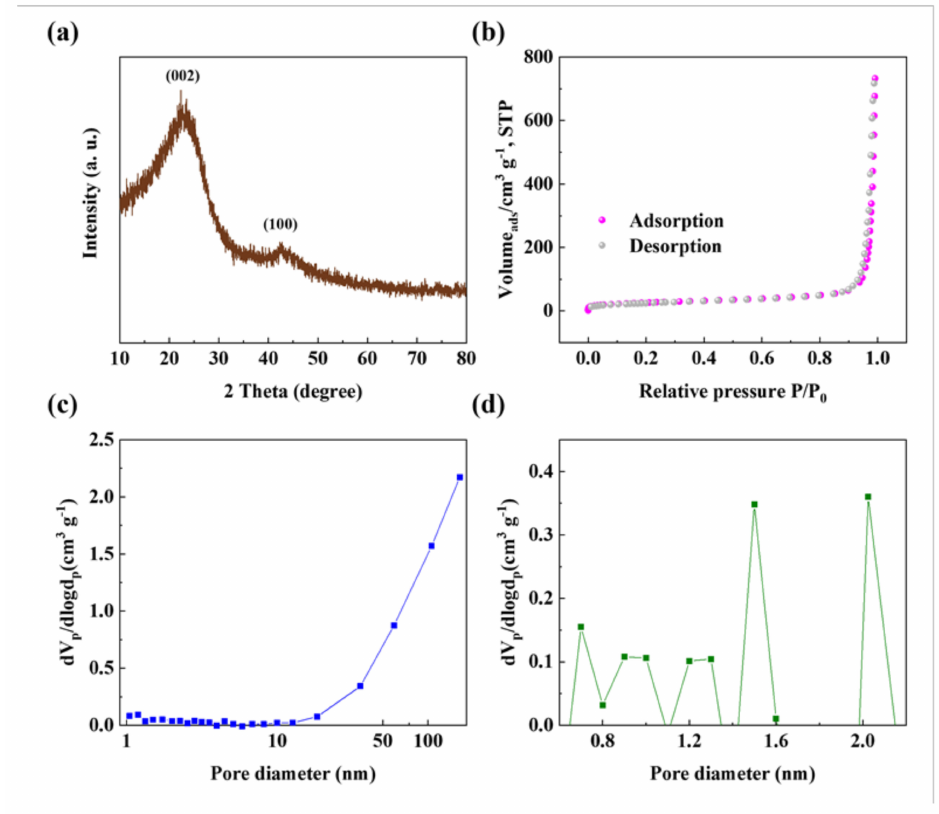
Figure 3. ( a ) XRD patterns of SP/C; ( b ) N 2 adsorption–desorption isotherm; ( c ) BJH pore size distribution; ( d ) micropore size